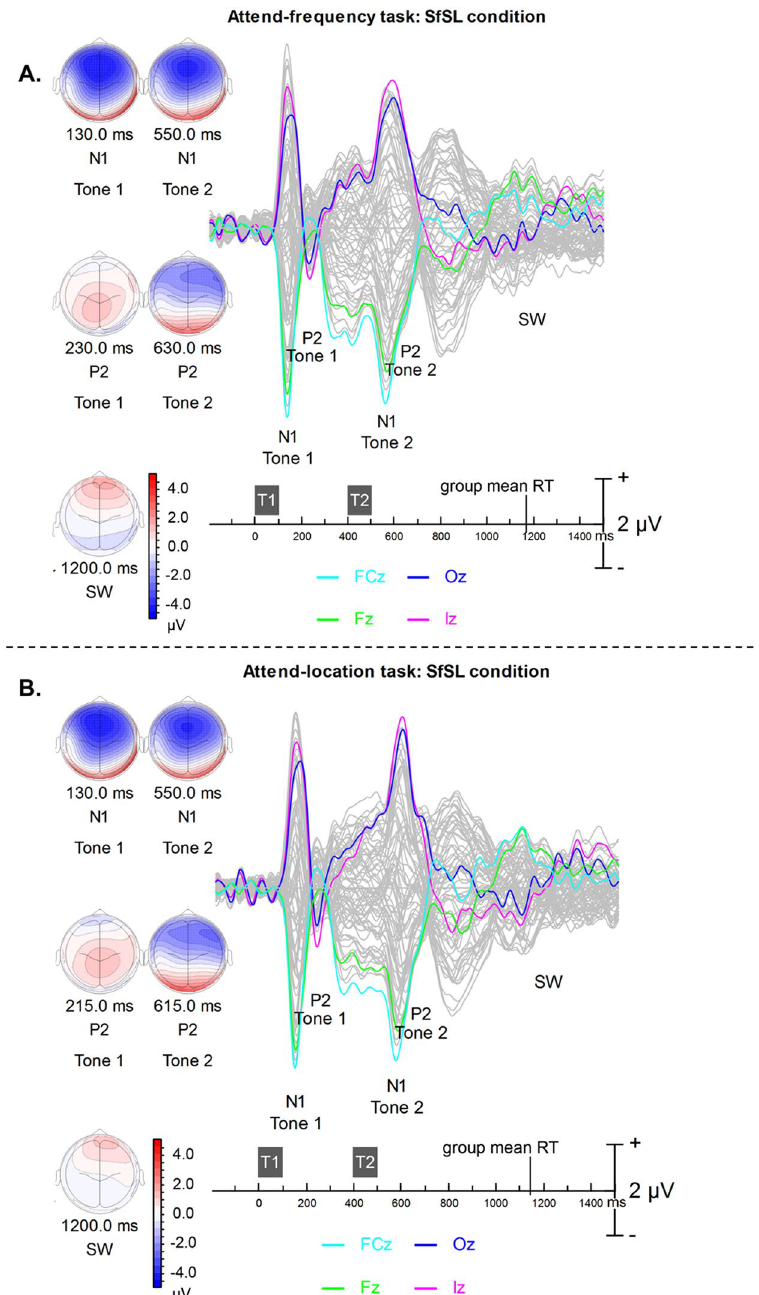
Figure 3. Group mean event-related brain potentials (for 65 channels) averaged over all SfSL trials from ( A ) attend-frequency and ( B ) attend-location TAiL tasks. The FCz electrode is shown in turquoise, Fz in green, Oz in purple and Iz in pink, all other channels are shown in gray. T1 = first tone; T2 = second tone. Isopotential contour maps are shown for the N1 (115 ms and 100 ms, respectively), P2 (200 ms and 200 ms, respectively) for each tone and slow wave (SW). Group mean RT for Same frequency Same location trials was 772 ms for the attend-frequency task and 741 ms for the attend-location task, time-locked to the onset of the second